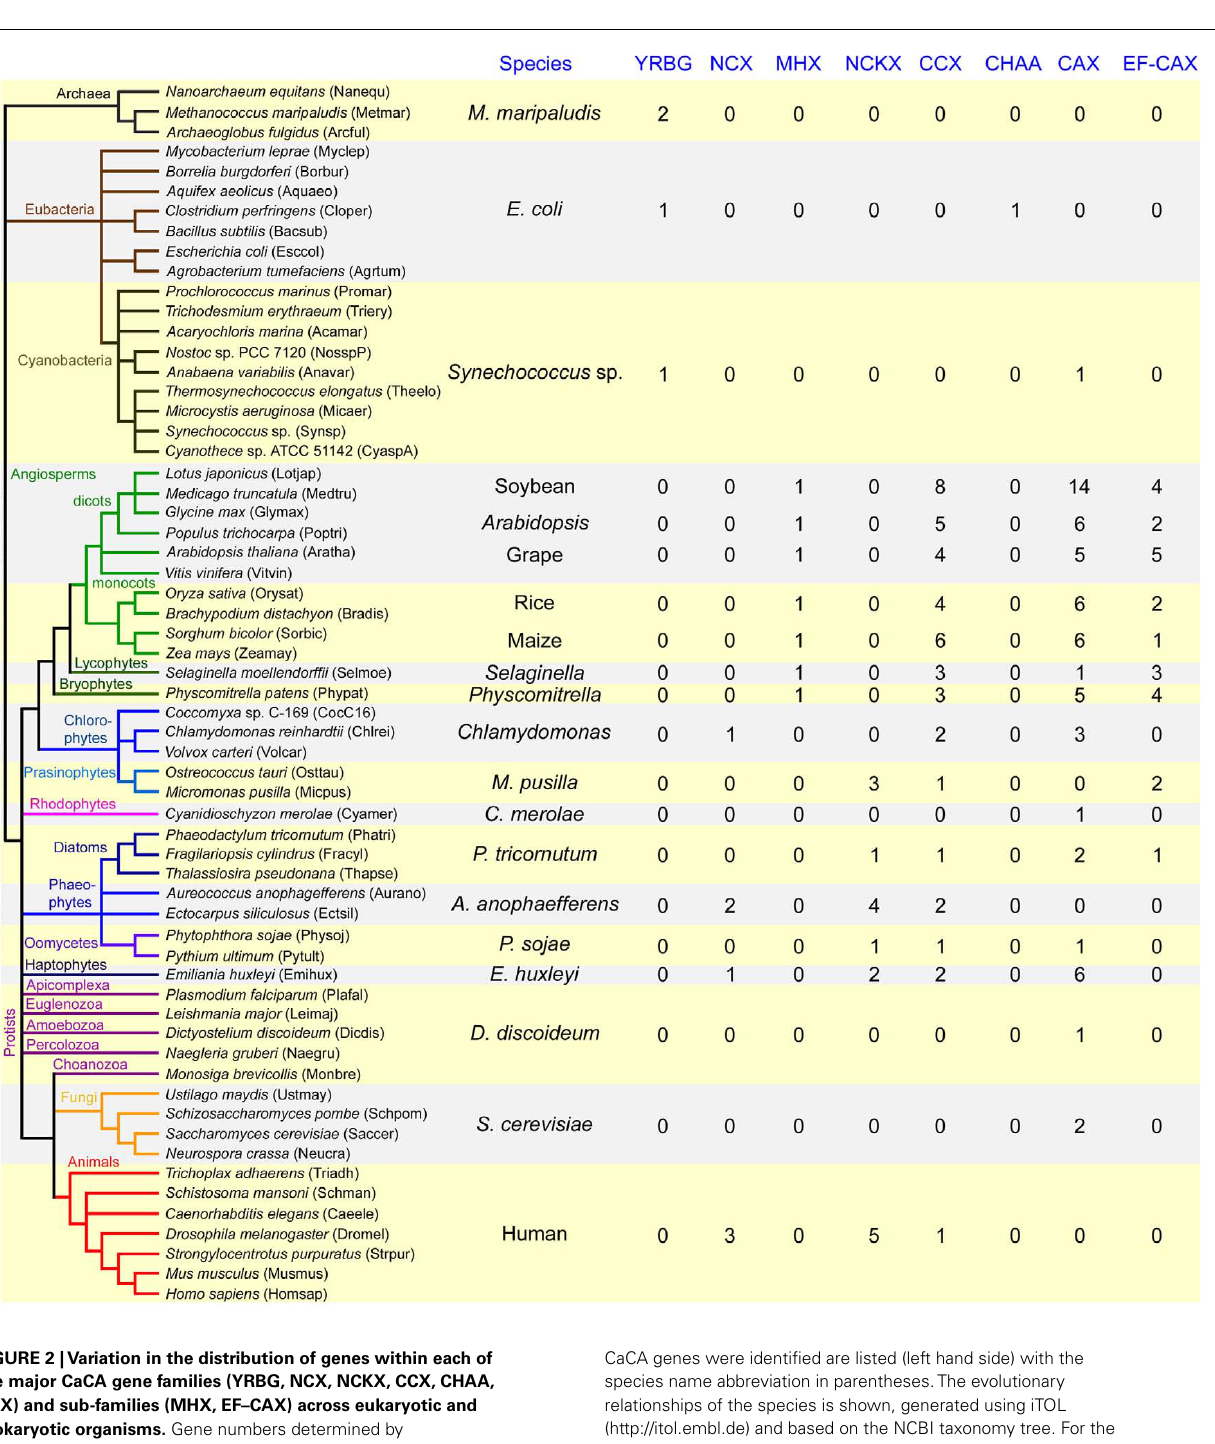
CaCA genes were identified are listed (left hand side) with the species name abbreviation in parentheses.The evolutionary relationships of the species is shown, generated using iTOL (http://itol.embl.de) and based on the NCBI taxonomy tree. For the full gene distribution for each of the species analyzed seeTable S1 in Supplementary